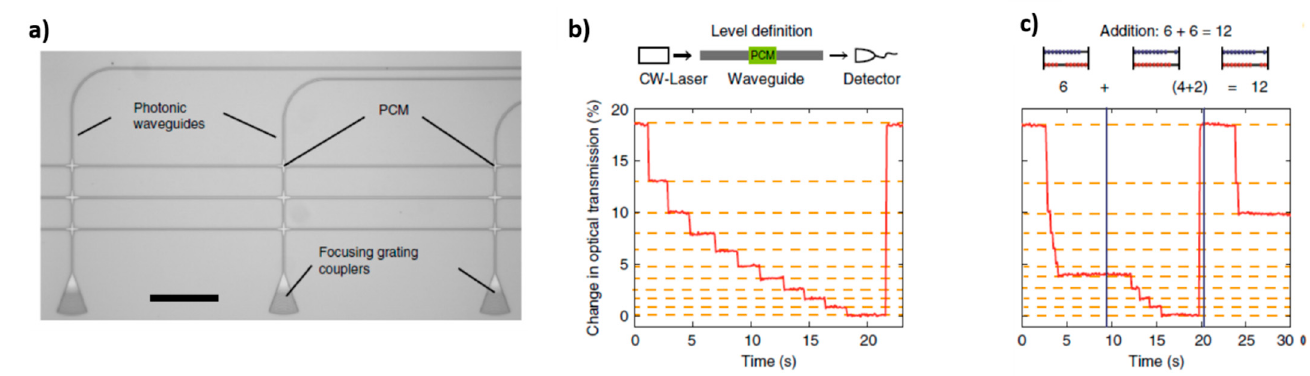
Figure 18. ( a ) Optical micrograph of a crossed-waveguide photonic array used as a memory device for the implementation of arithmetic calculation. Scale bar is 100 μ m; ( b ) level definition in a base-ten device; ( c ) example of addition: with the transmission levels defined in b), ‘6 + 6 = 12’ is calculated. By analogy to the operation of an abacus, a carryover is performed when the tenth level is reached, and the cell is reset to its initial state. The result ‘12’ is obtained from one carryover, which can be read in another cell (the corresponding to “tens”), and the final state of the illustrated PCM-cell, which is at level 2. Reproduced from Ref. [117] with permission from Nature Springer.